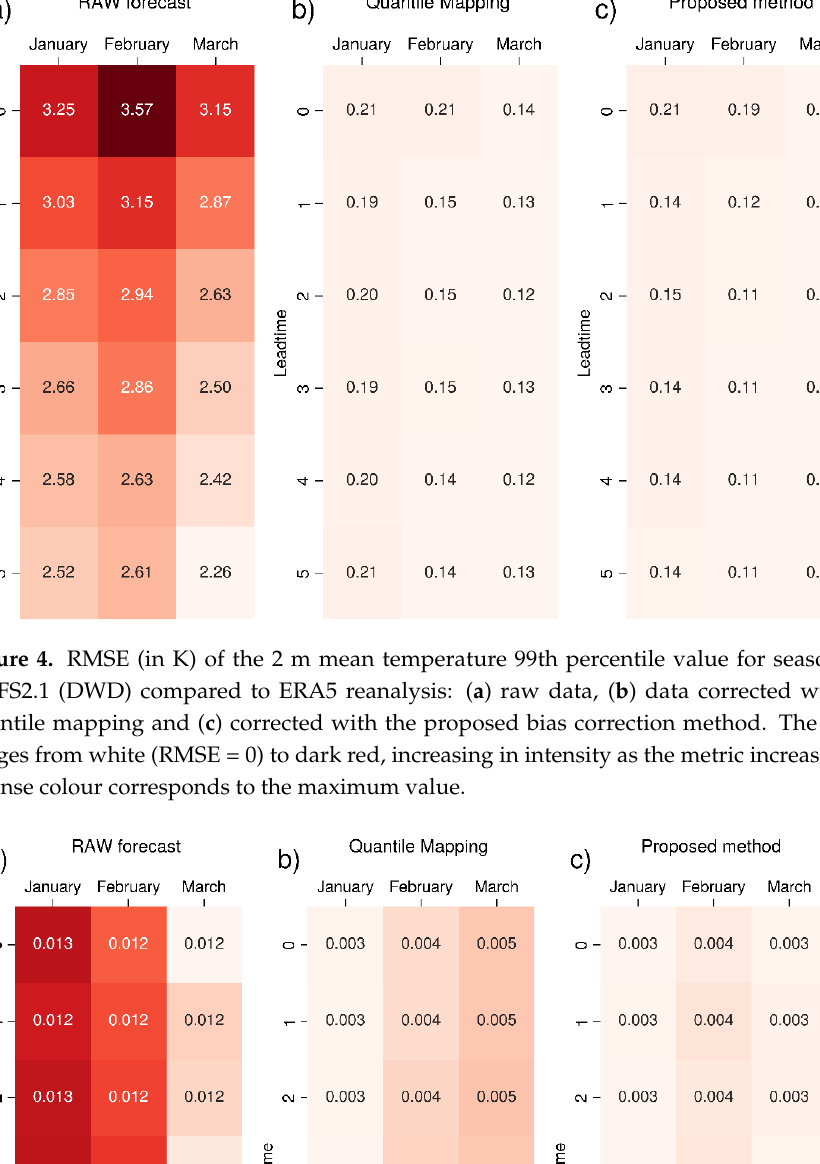
Figure 3. RMSE (in K) of the 2 m mean temperature 99th percentile value for seasonal forecast Sys- tem 7 (Météo-France) compared to ERA5 reanalysis: ( a ) raw data, ( b ) data corrected with standard quantile mapping and ( c ) corrected with the proposed bias correction method. The colour scale ranges from white (RMSE = 0) to dark red, increasing in intensity as the metric increases. The most intense colour corresponds to the maximum value.